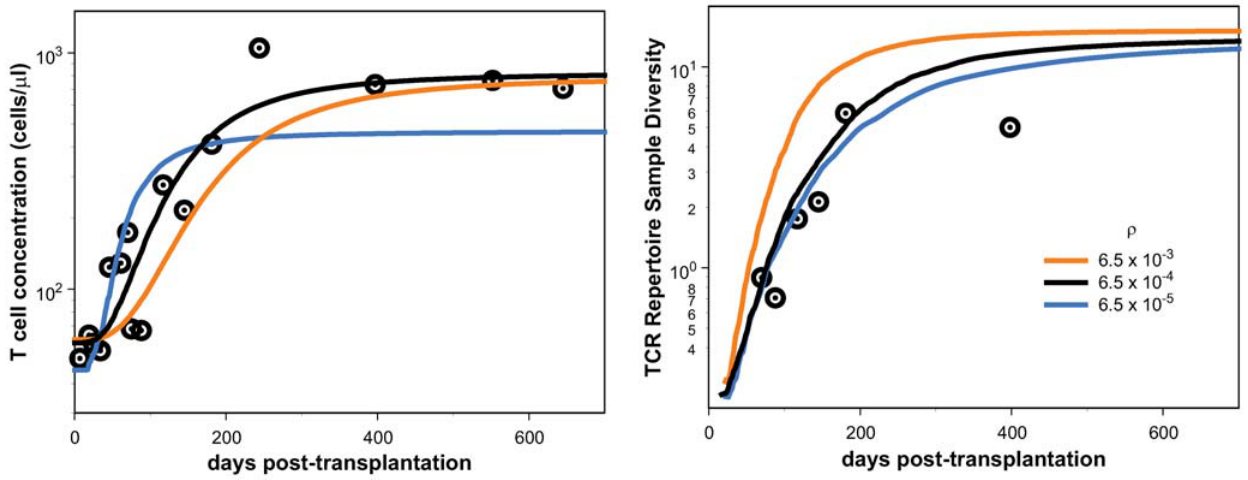
Figure 4. Best fit for constant r . Maximum-likelihood fit of data from subject 1 to the population-dynamic model given by Eqs.(1,4). The black curve represents the maximum likelihood solution; the orange and blue curves represent the maximum likelihood solutions subject to a constraint on r at the values indicated. The curves are the trajectories of c 0 z h T and D , respectively.